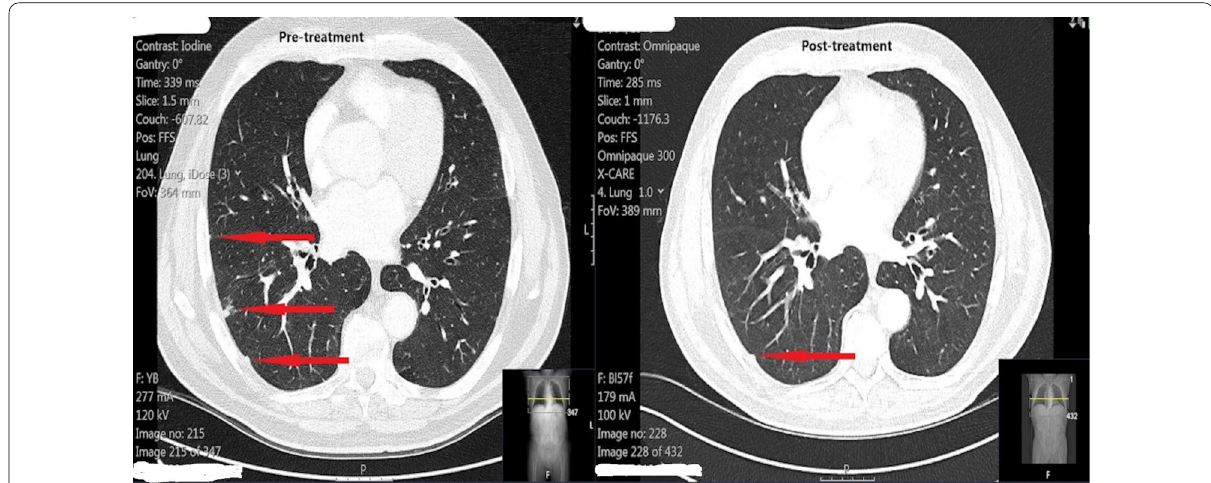
Fig. 1 Axial images of chest CT scans (left) performed before initiation of anti-tuberculosis medications, compared with Axial CT Chest image at same level on the right, 4 months after commencing treatment. There is significant improvement in subpleural nodules, as pointed by red arrows